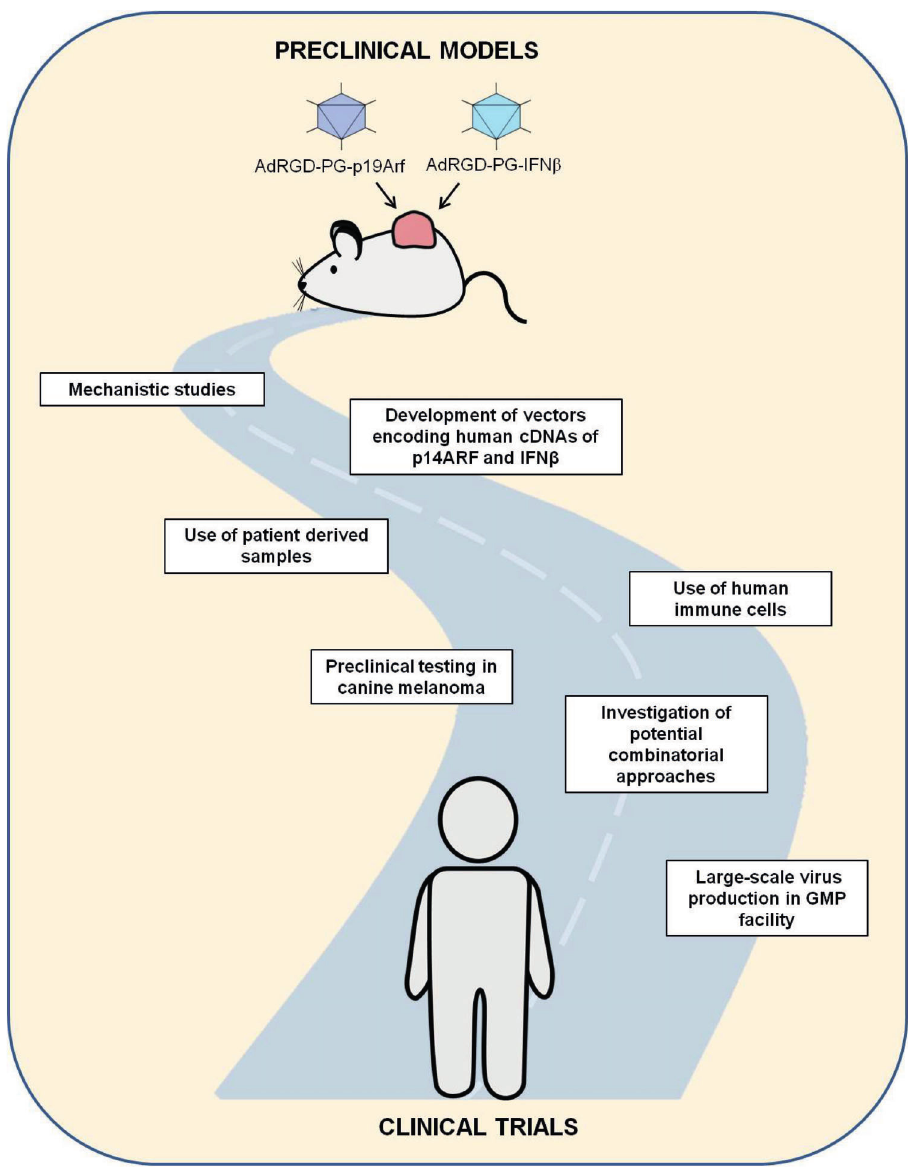
Figure 1 - Schematic representation of the challenges and perspectives of continuing along the road of translational research. Critical milestones include testing our approach in human cells, including patient-derived tumor and immune cells, and models of spontaneous tumors, such as canine melanoma. In addition, the combination of our approach with chemotherapy or other immunotherapies may enhance efficacy. Virus production following good manufacturing practices (GMP) is critical for providing not only larger quantities of vectors but also biological agents of pharmaceutical